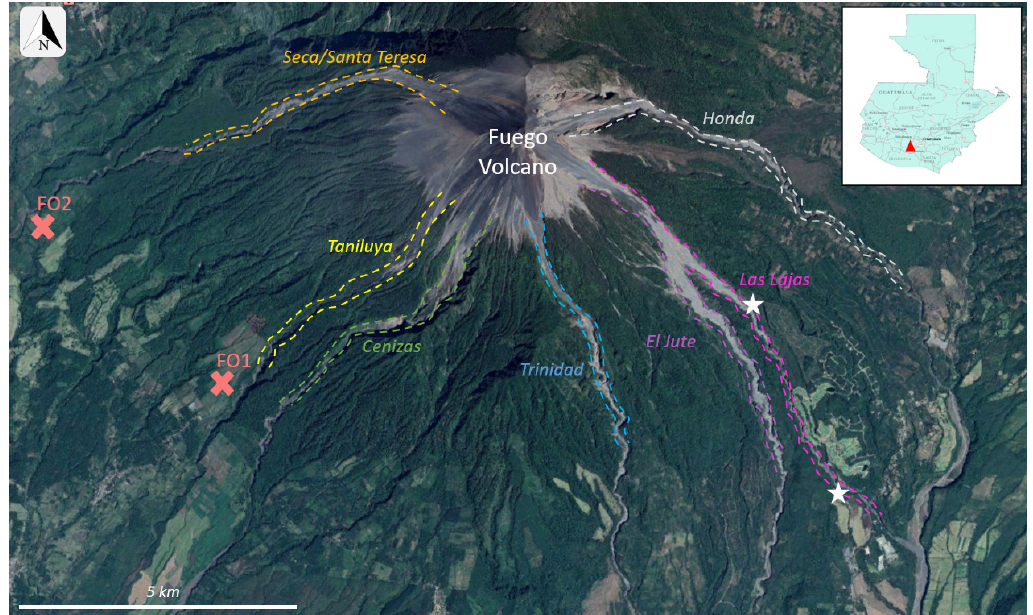
Figure 1. Google Earth image of Fuego volcano annotated to show the seven primary barrancas (ravines) that are radially distributed to the west, south and east. Small lava flows, pyroclastic density currents (PDCs), and lahars are typically confined to these seven barrancas. The white stars indicate the two locations where the 3 June 2018, PDC exited the Las Lajas barranca. The two National Institute of Seismology, Volcanology, Meteorology, and Hydrology (INSIVUMEH) volcano observatories are shown by the red X marks (labeled FO1 and FO2).